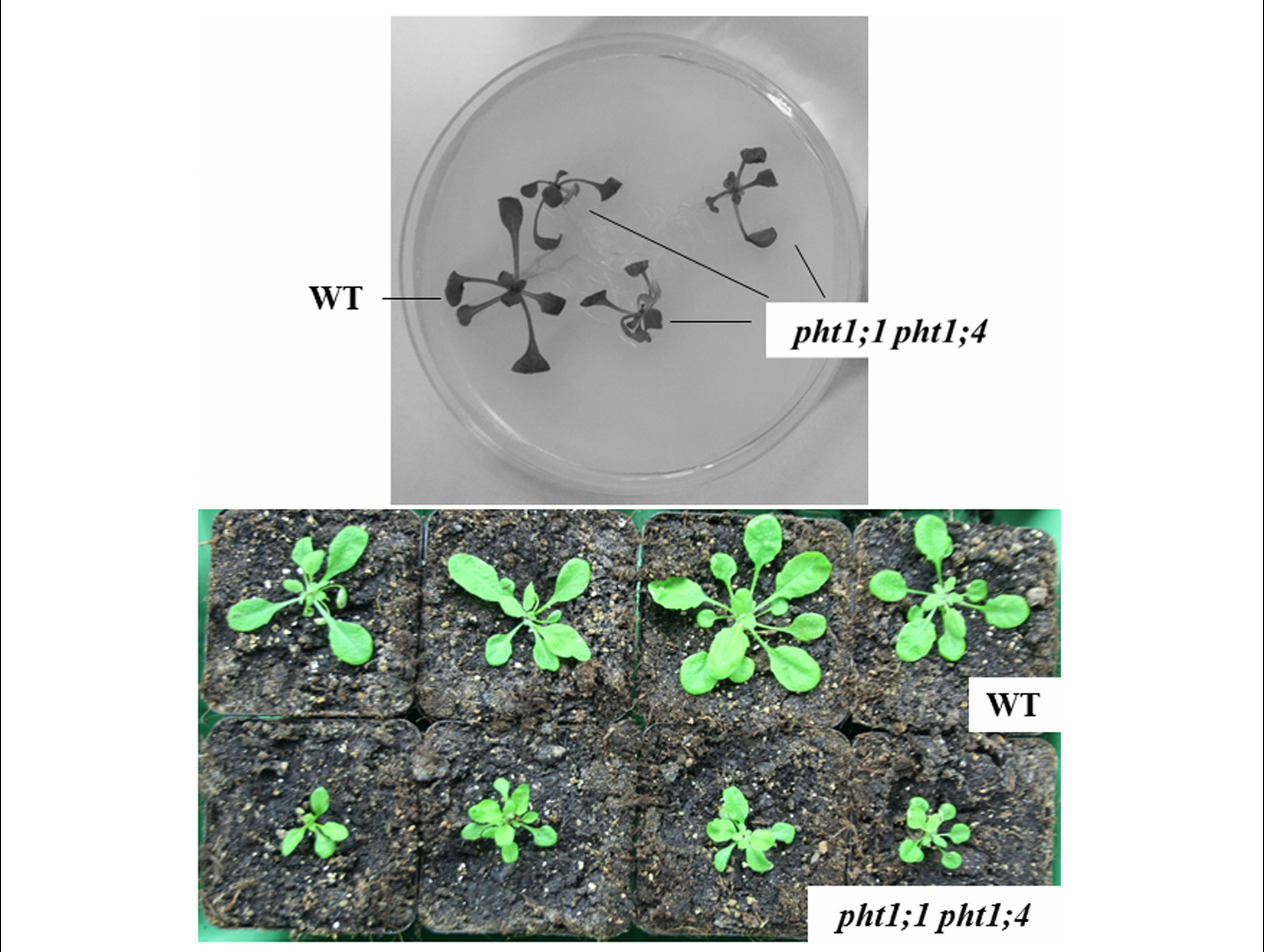
FIGURE 6 | Phenotype of WT and pht1;1 pht1;4 seedlings/plants. Top: After 10 days, WT and pht1;1 pht1;4 seedlings were transferred to PNM medium with NP for 3 weeks. Bottom: Arabidopsis WT (upper 4 plants) and pht1;1 pht1;4 double knock-out lines (lower 4 plants) were grown in Petri dishes for 10 days before transfer to soil for additional 4 weeks. Growth occurred in a greenhouse.